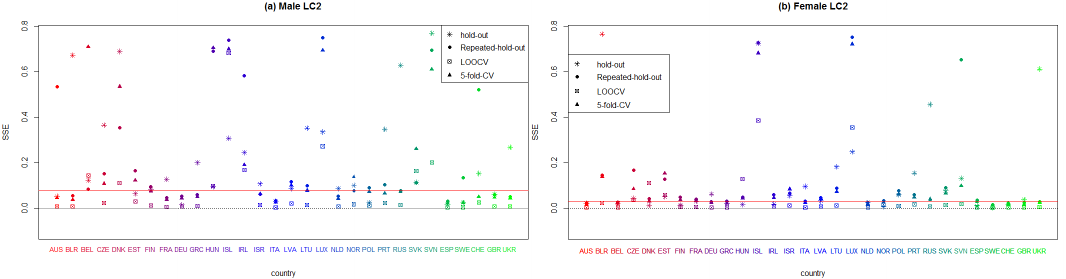
Figure A2. Plot summarizing the mean absolute measure (MAE) of each European country that applies the unifactorial Lee–Carter model to males and females, according to every employed resampling method.